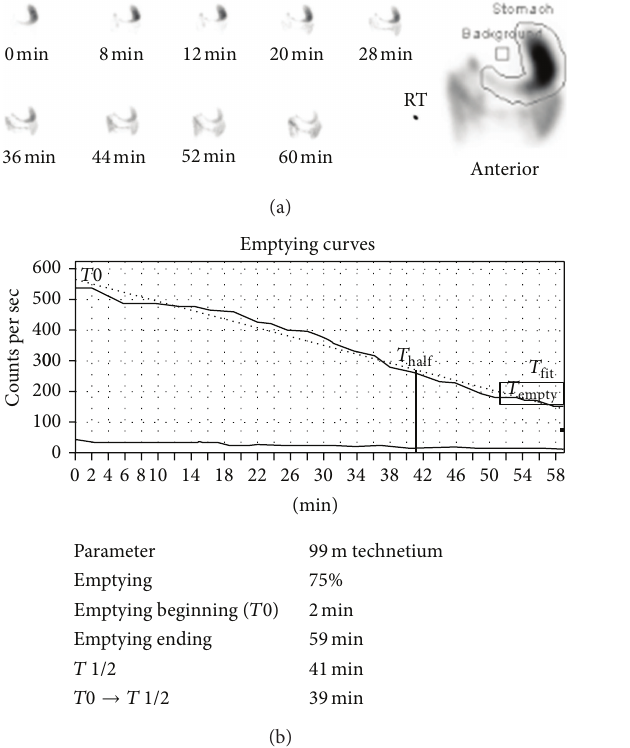
Figure 3: Gastric emptying study for patient KS following intrapy- loric botulinum toxin injection. (a) Gastric emptying was observed for 60 minutes with intermittent imaging. The region of interest is indicated at right by a line drawn around the activity within the stomach in the anterior view. (b) The emptying curves over 60 —solid; 𝑇 —dotted) are shown. The half-emptying minutes ( 𝑇 empty fit time ( 𝑇 1/2) was calculated using the geometric mean. Gastric emptying time was normal with 75% emptying over 60 minutes and a half-emptying time of 41 minutes.